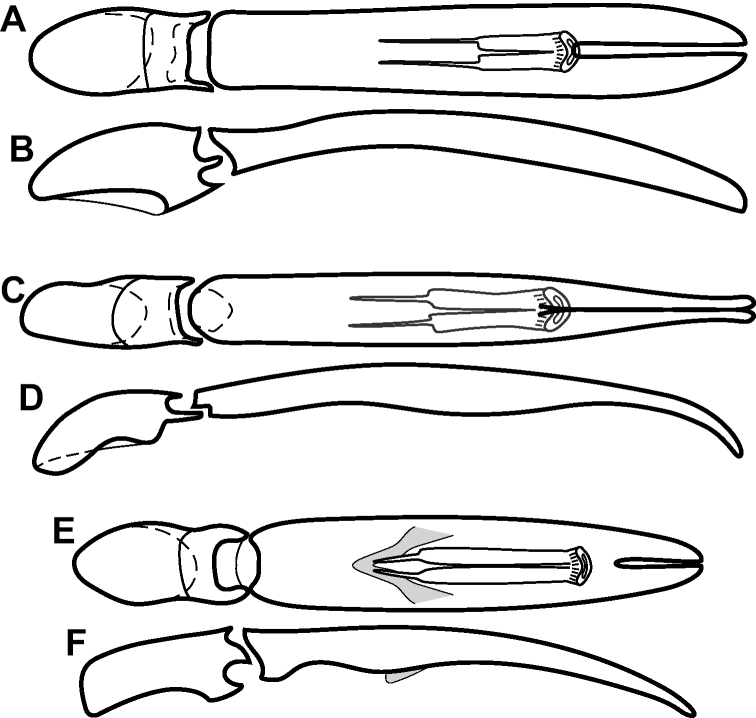
Male genitalia A, BPhelister
globosus: A aedeagus, dorsal B aedeagus, lateral C, DP.
serratus: C aedeagus, dorsal D aedeagus, lateral E, FP.
parana: E aedeagus, dorsal F aedeagus, lateral.